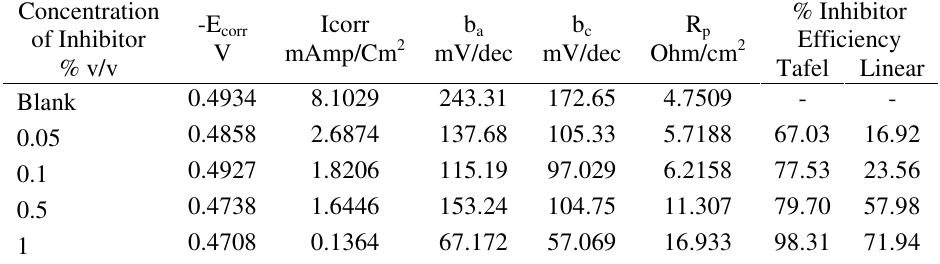
Potentiodynamic polarization parameters for mild steel in 1N H presence of NAL